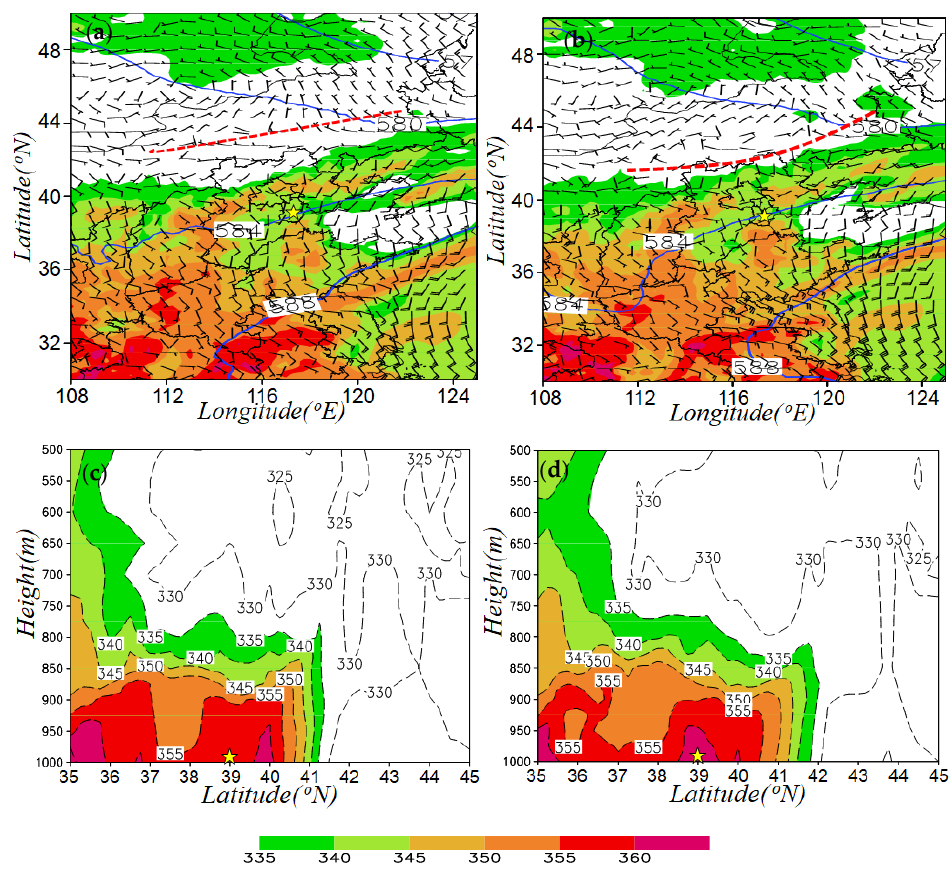
Figure 4. Pseudo-equivalent potential temperature (colored, unit: K) at 850 hPa, horizontal wind barbs at 925 hPa, and geopotential height (solid contour, unit: dgpm) at 500 hPa at ( a ) 14:00 BT and ( b ) 17:00 BT on 1 August 2019; the red dashed lines represent convergence line at 925 hPa. Cross- section of the pseudo-equivalent potential temperature (colored and dash contour, unit: K) along 117 ◦ E at ( c ) 14:00 BT and ( d ) 17:00 BT on 1 August 2019. The yellow pentagram is used to indicate the position of the